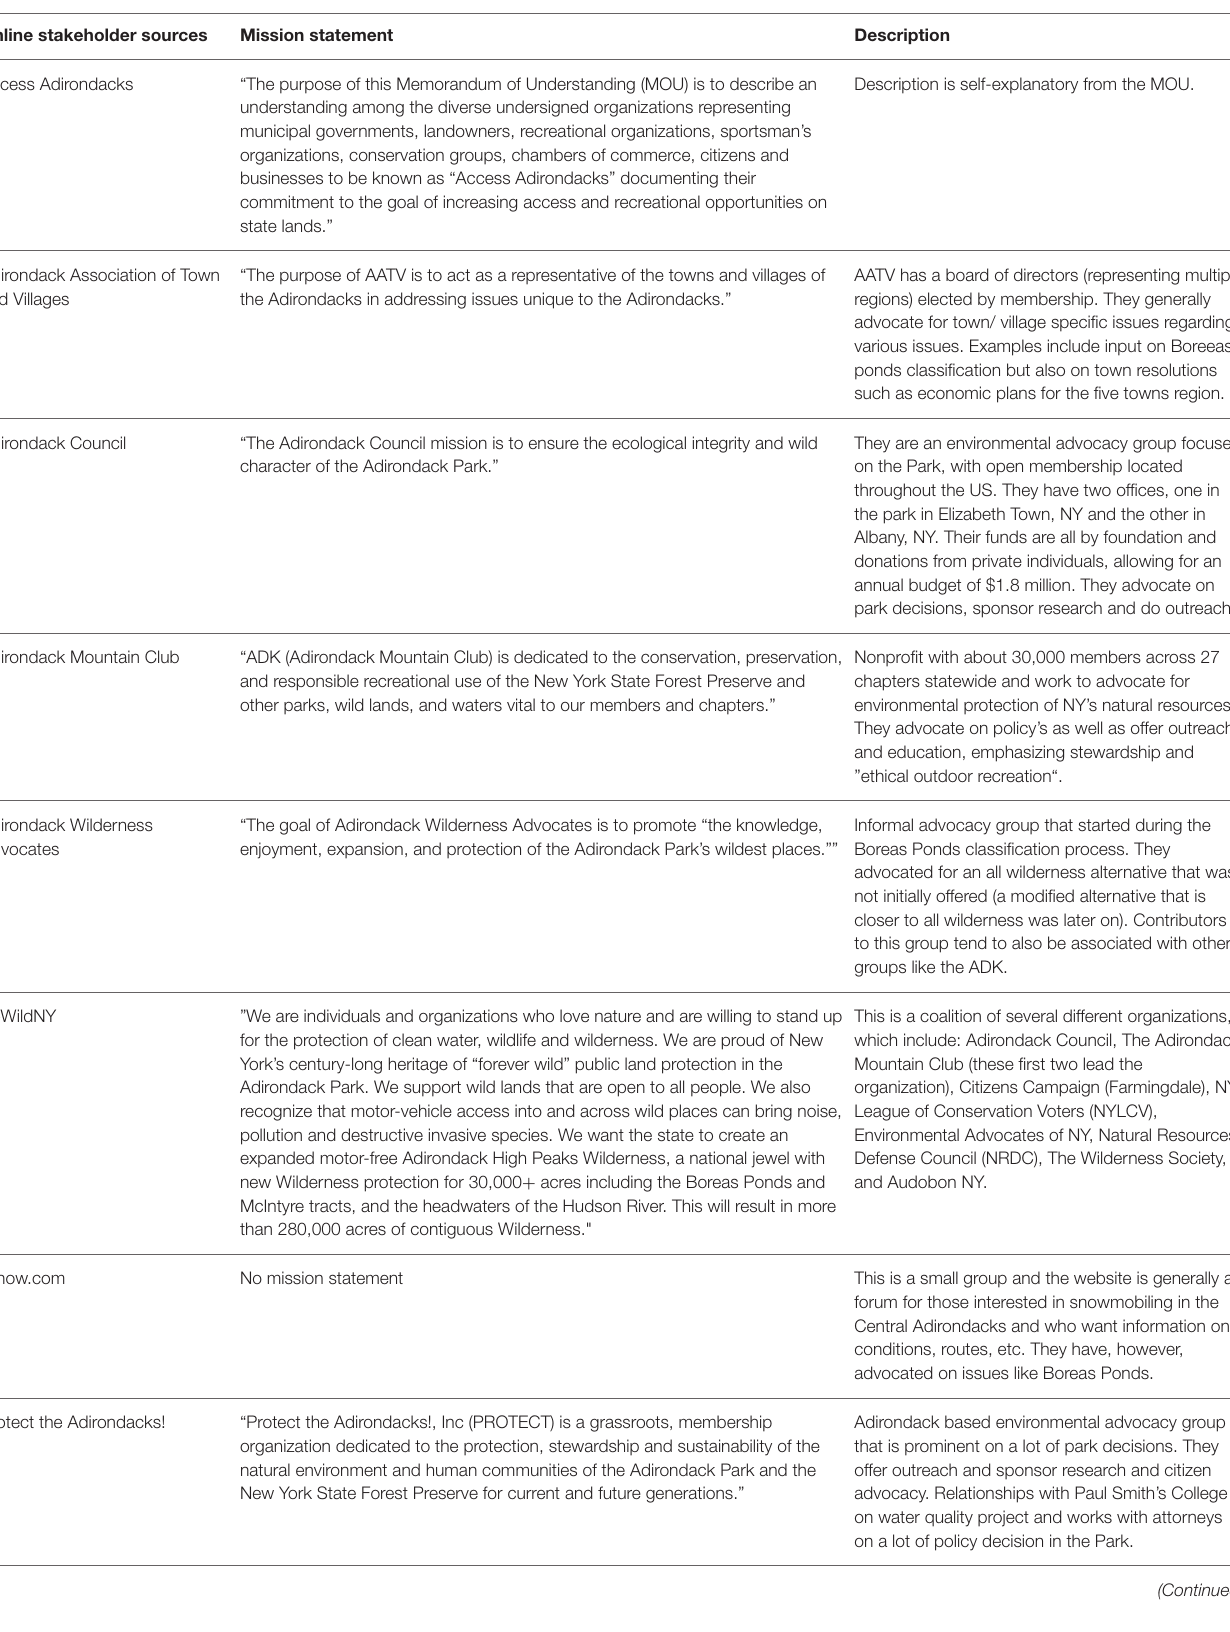
TABLE 1 | List of Online Stakeholder